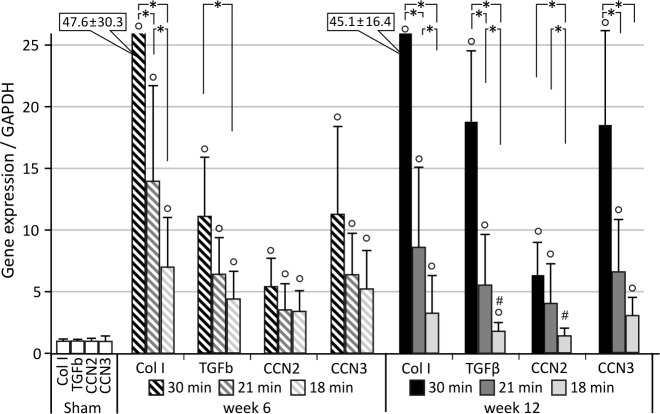
Relative quantification of long-term IRI-induced expression of fibrosis-related genes.Duration of ischemia determines degree of long-term fibrotic outcome. *: p<0.05, °: p<0.05 vs. Sham, #: p<0.05 vs. week 6. UIRI was performed for 30, 21 or 18 minutes at 36°C and animals were euthanized 6 weeks (resp. n = 5, n = 12, n = 6) and 12 weeks (resp. n = 4, n = 5, n = 10) after UIRI. Six weeks after 30, 21 and 18 minutes of UIRI, a significant increase in gene expression of fibrosis-related genes Col I, TGFβ, CCN2 and CCN3 was observed. 12 weeks after 30 and 21 minutes of UIRI, although not statistically significant, a further increase in gene expression of these genes is observed. However, 12 weeks after 18 minutes of UIRI, a trend to decreased gene expression of Col I and CCN3 and a significant decrease in of TGFβ and CCN2 is observed. The bars are the means ± s.d. The data were analysed using a two-tailed Mann-Whitney U test.